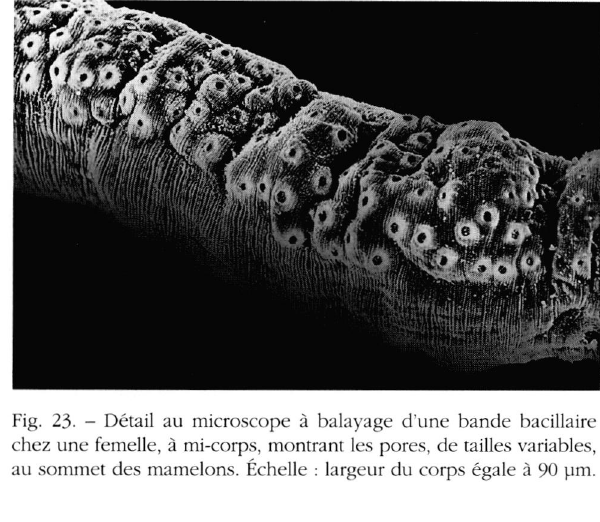
Fig. 23. - Détail au microscope à balayage d'une bande bacillaire chez une femelle, à mi-corps, montrant les pores, de tailles variables, au sommet des mamelons. Échelle : largeur du corps égale à 90